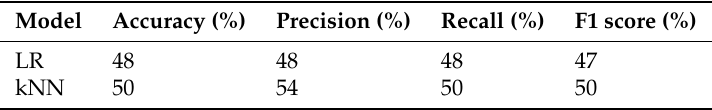
Table 4. Metric scores obtained by using the models fitted to standardized phantom data on testing the in vivo dielectric property